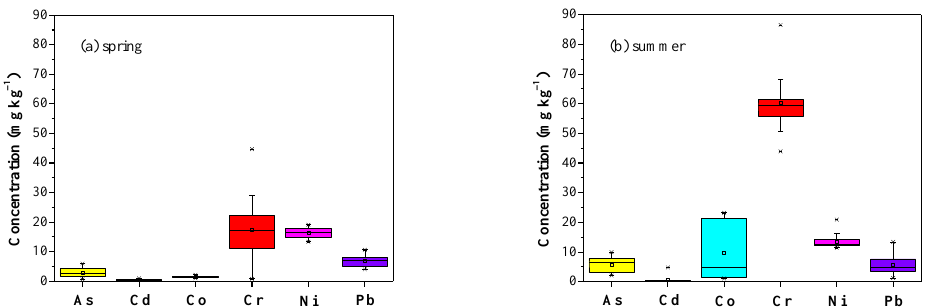
Figure 2. Box plots of the concentrations of heavy metals from indoor dust samples in Asaluyeh in spring ( a ) and summer ( b ). The bottom and top of the box are the first and third quartiles, respectively, while the mean is denoted by circle and the median by line within the boxes. Whiskers (the vertical lines) are the 1.5 interquartile ranges of the lower and upper quartiles.